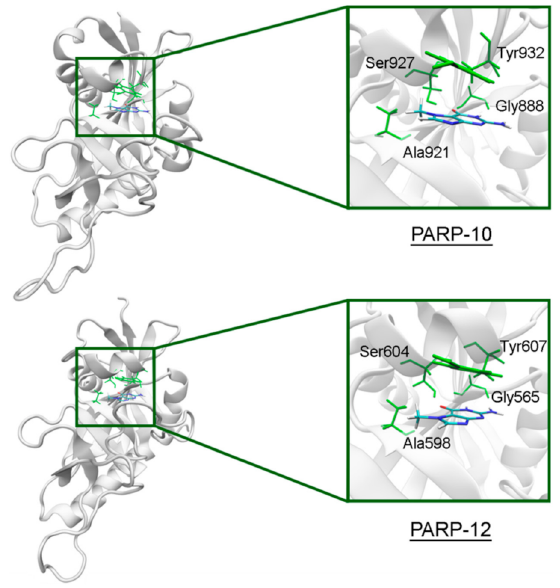
Figure 6. 7-MG position in the NA binding site of PARP-10 and 12 obtained using MD modeling. The NA site residues are colored in